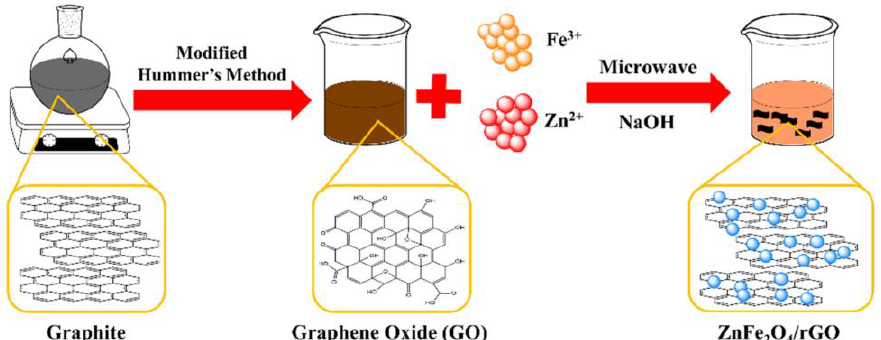
Figure 1. Scheme of the preparation of ZFG nanomaterial.